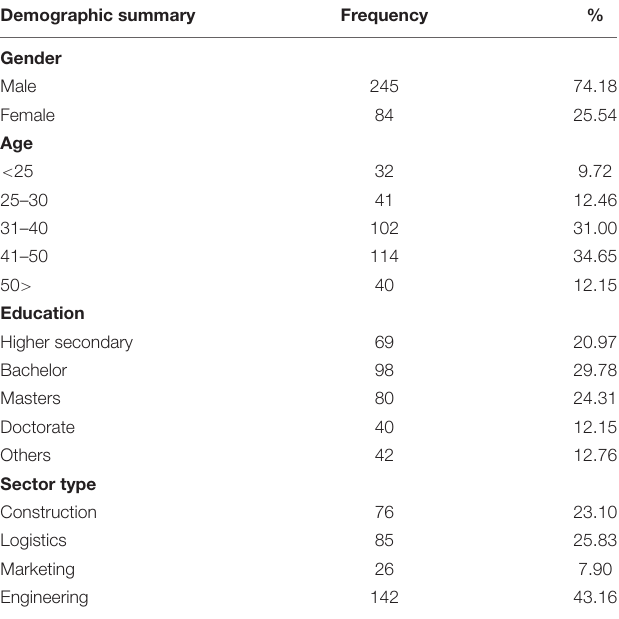
TABLE 1 | Demographic